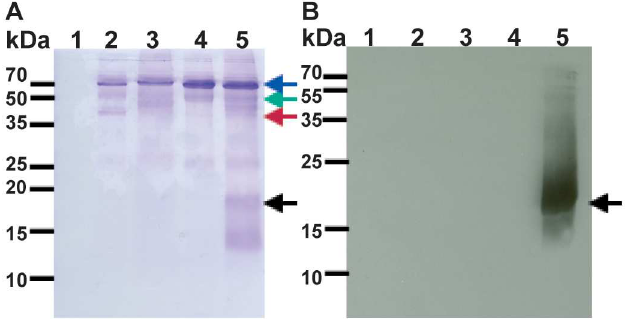
Fig 11. Co-immunoprecipitation of PelB-Vpu with CD4. Purified CD4 TMD + cytoplasmic domainfused to the amino end of MBP (CD4-MBP) was incubatedwith PelB-Vpu in β DDM micelles. The complex was capturedby anti- MBP antibody-conjugated beads and pelletedby centrifugation and analyzedby SDS-PAGE followedby Coomassie staining( A ) and immunoblot analysiswith Vpu antibodies( B ). Panel A depicts all proteinspulleddown by only agarosebeads(lane 1) and agarosebeadsconjugatedwith anti-MBP (lanes 2–5). Anti-MBP, CD4-MBP, MBP and Vpu are denotedby blue, green, red and black arrows respectively. Beads were incubatedwith purifiedproteins: CD4-MBP (lane 1), MBP and Vpu (lane 2), CD4-MBP (lane 3), Vpu lane 4), CD4-MBP and Vpu (lane